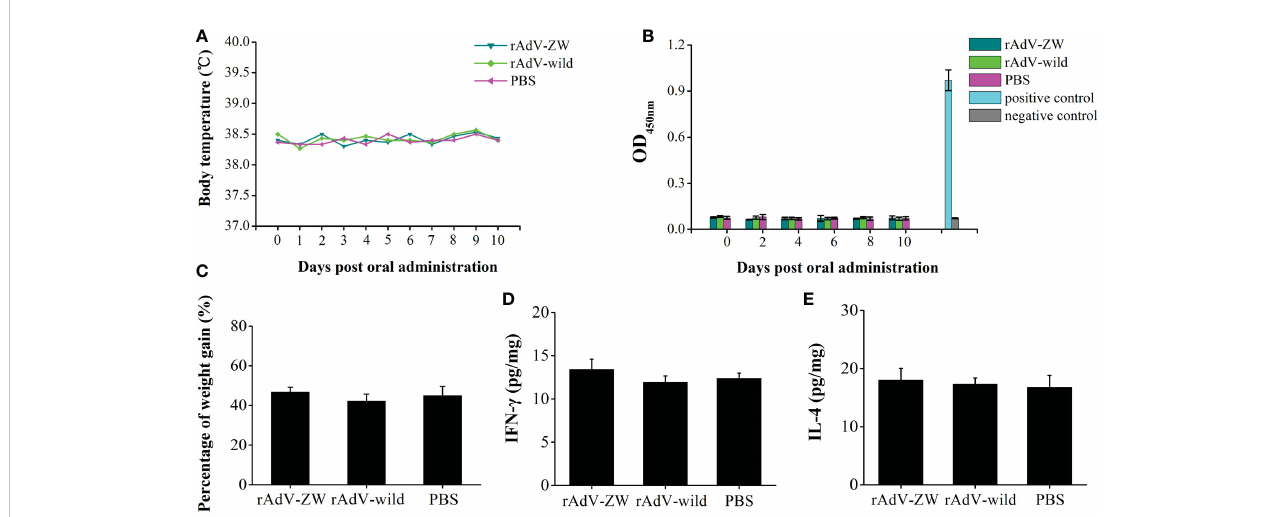
FIGURE 2 Biosafety rAdV-ZW testing. Three-day-old piglets were orally administrated 2 mL 10 10 TCID 50 rAdV-ZW, 2 mL 10 10 TCID 50 rAdV-wild-type, and 2 mL PBS. (A) The rAdV-ZW effects on rectal temperature. After administration, piglet temperatures were measured daily. (B) Viral shedding determined by ELISA. After administration, feces samples were collected at one day intervals. (C) Piglet percentage weight gain after rAdV-ZW administration. Jejunal (D) IFN- g and (E) IL-4 expression by ELISA at day 10 after oral administration. Values are presented as the mean ± standard error of the mean